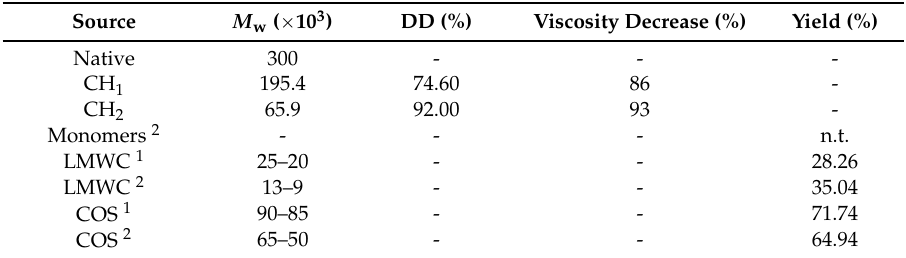
Table 5. Properties of degraded chitosan.